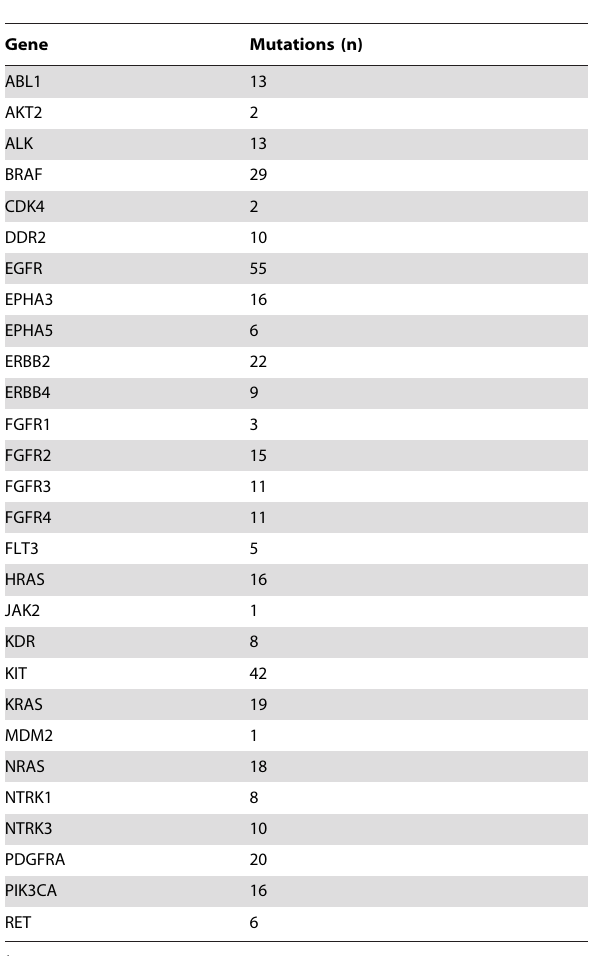
Table 1. List of genes with number of mutations (n) screened for in OncoMap 1